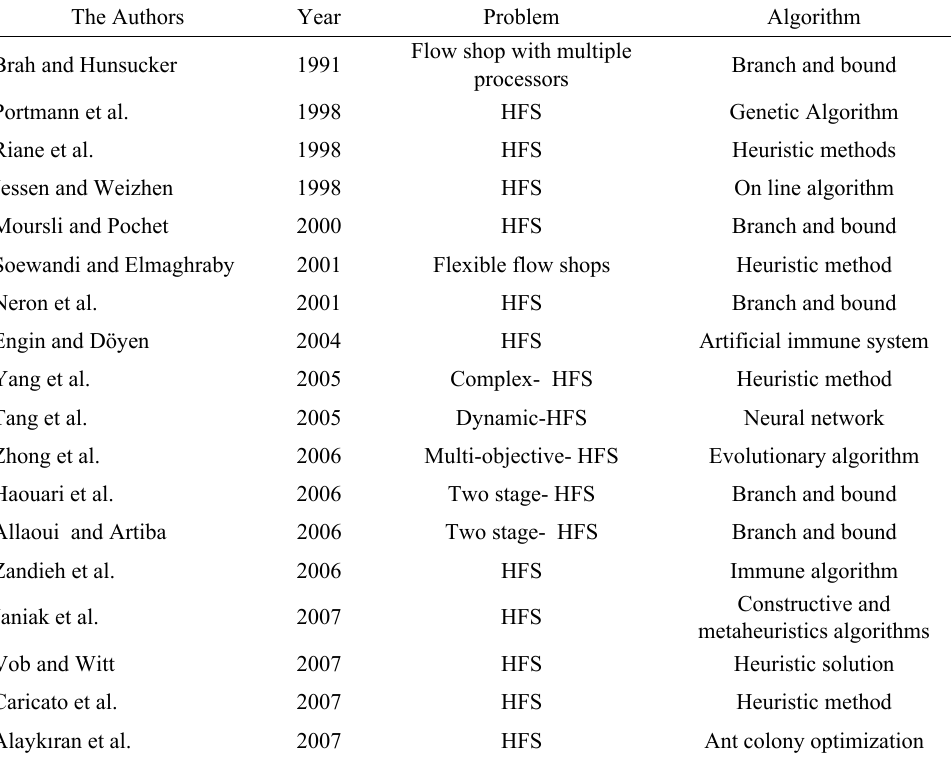
Table 1. Literature review on HFS scheduling